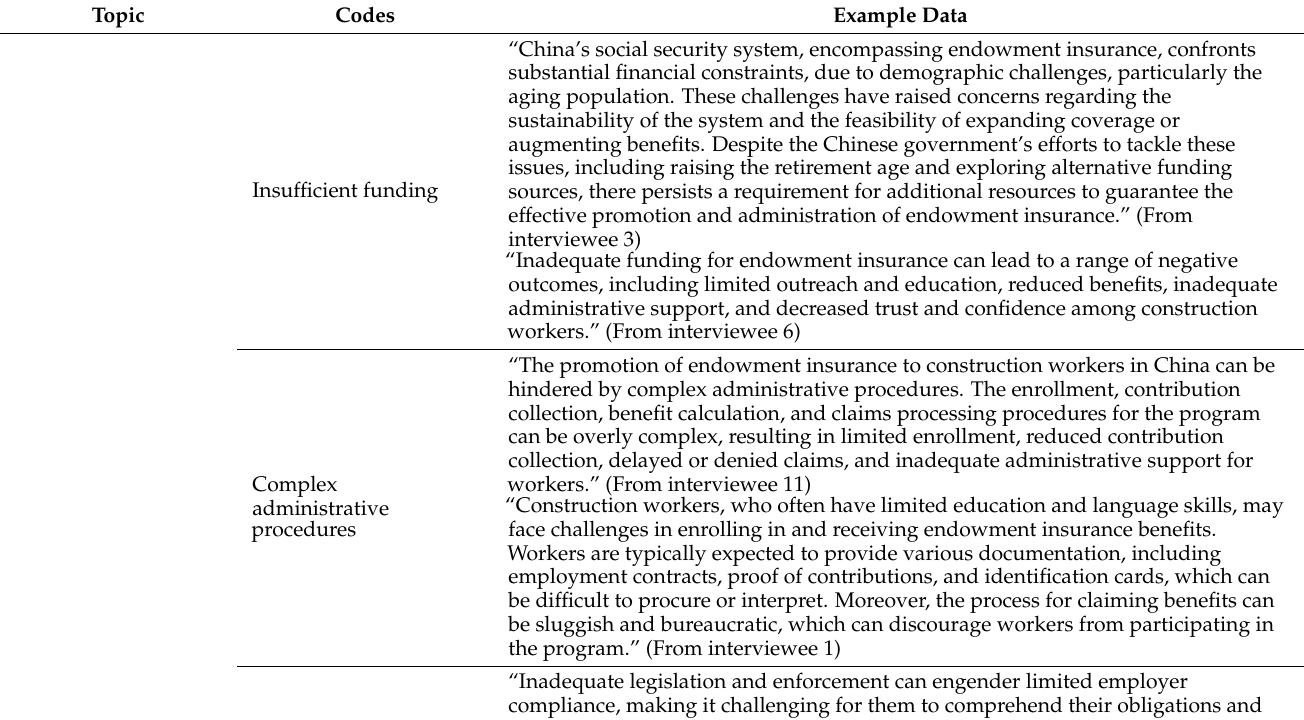
Table 4. Thematic analysis process of